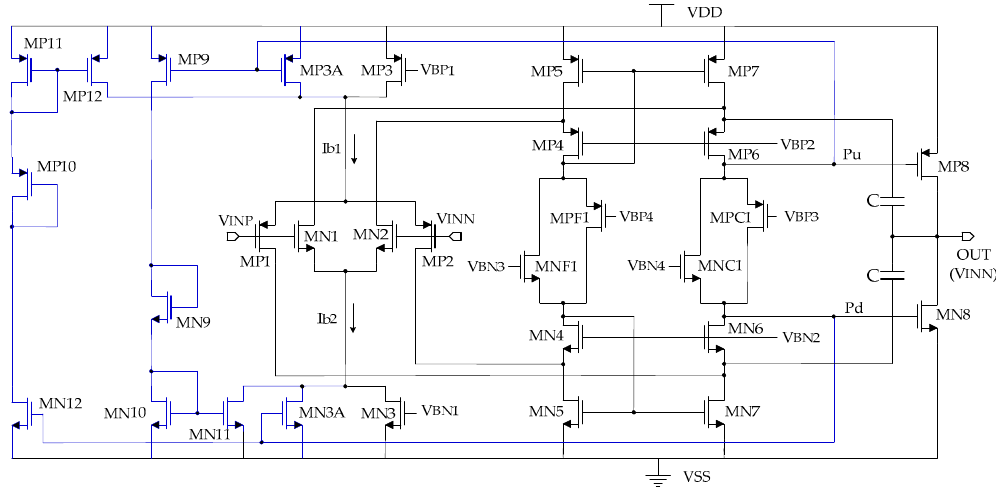
Figure 2. Proposed buffer amplifier with area- and power-efficient slew rate enhancement throughout entire rail-to-rail signal range.